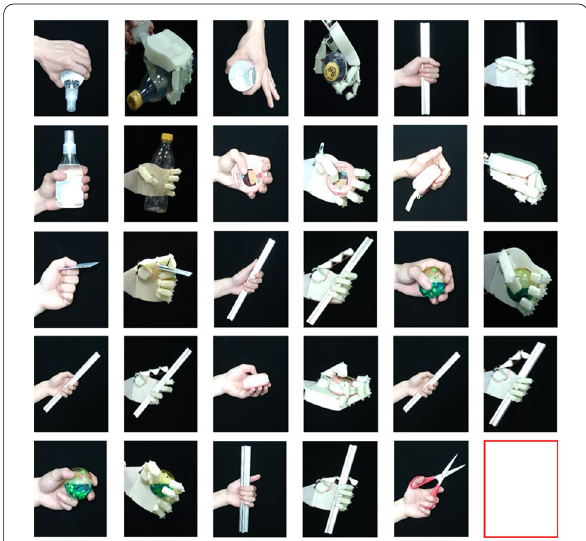
Figure 9 Comparison of prosthetic hand and human hand in motion